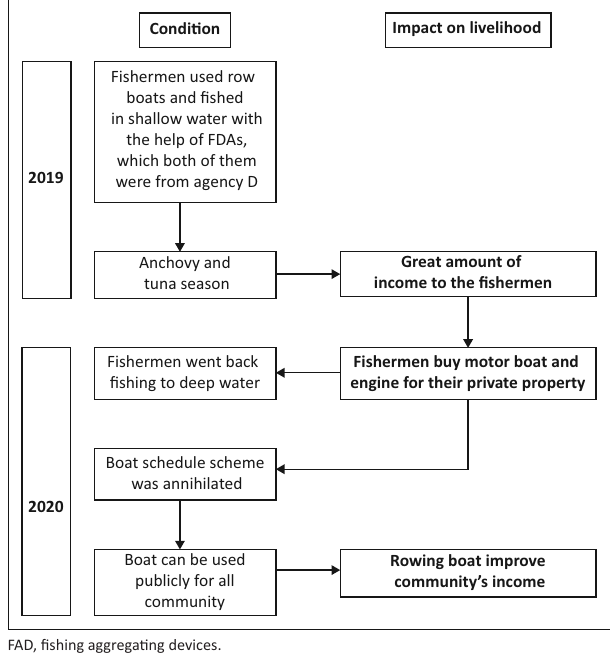
FIG URE 7: The impact on livelihood 2 years after the community-driven project.